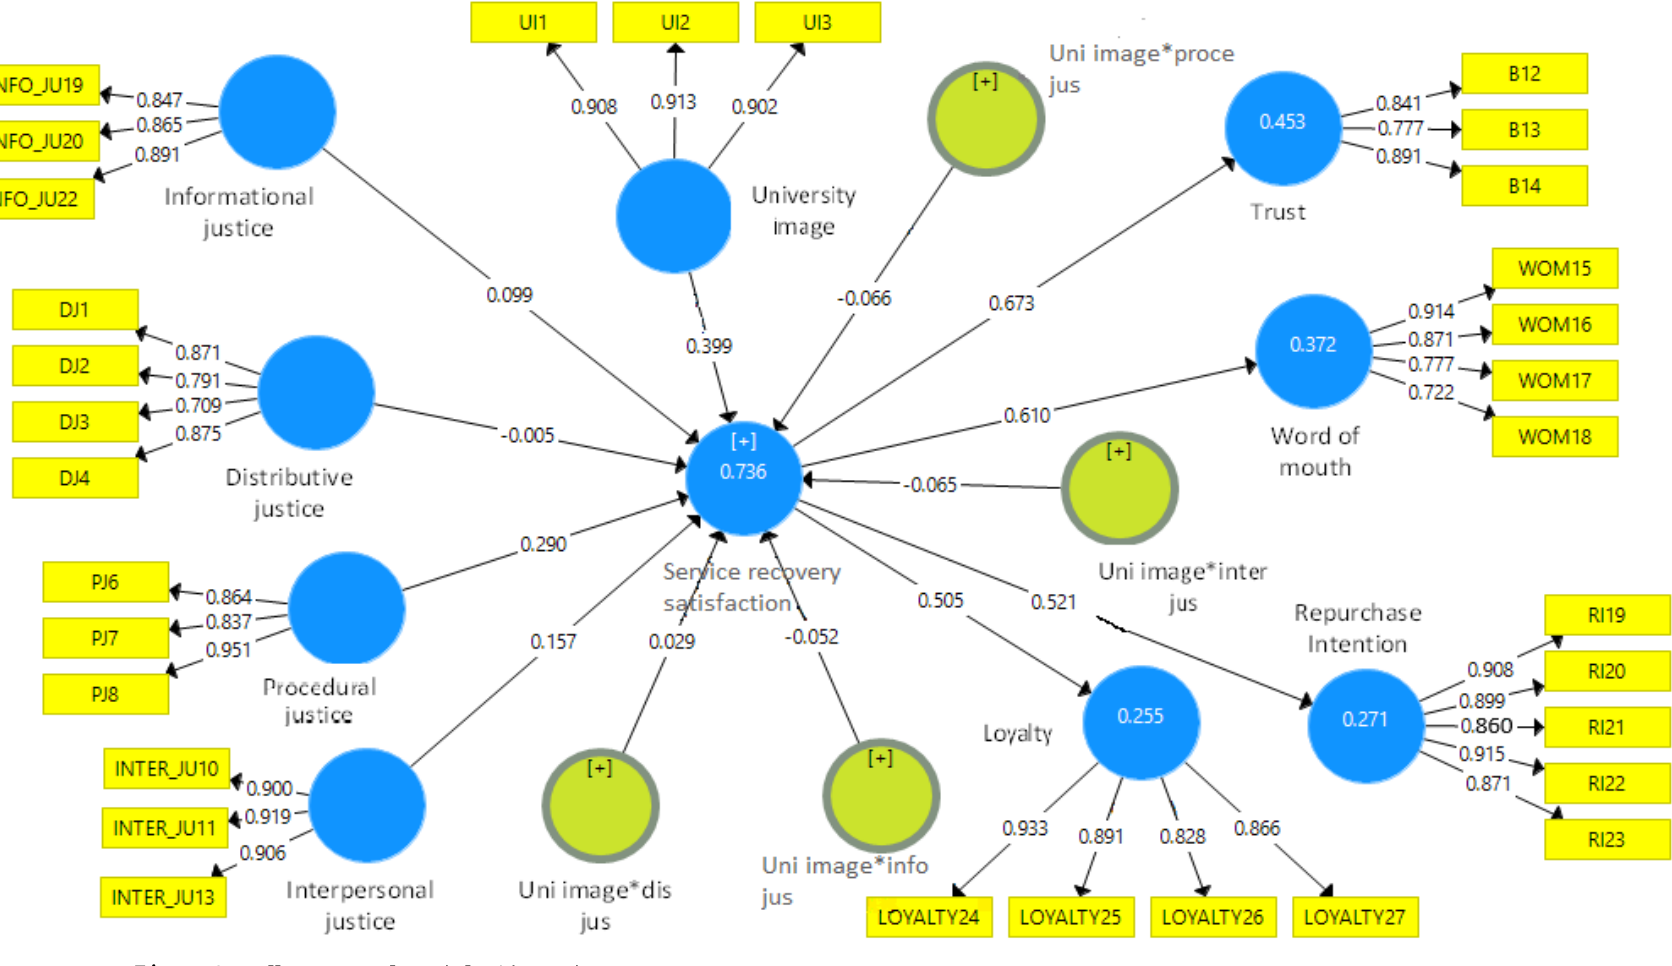
Figure 2. Full structural model with